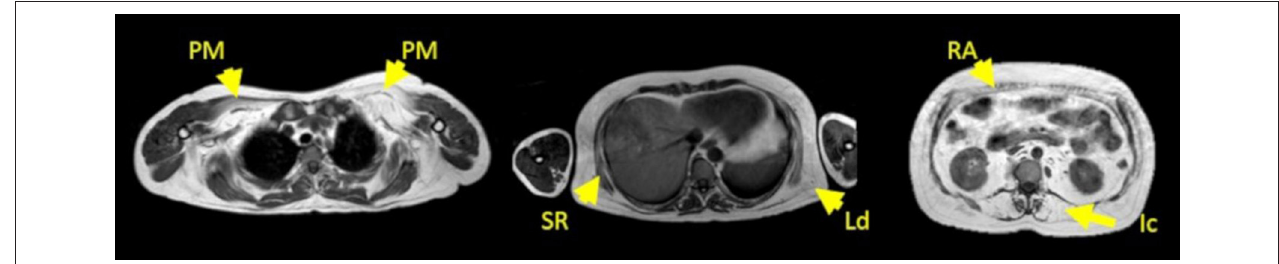
FIGURE 4 | MRI T1w of patient 14 at first visit. From left to right, first image corresponds to shoulder girdle level; second image corresponds to a thoracic level, and third image corresponds to an abdominal level. Yellow arrows point to the pectoralis major (PM), serratus (SR), latissimus dorsi (Ld), rectus abdominis (RA), and iliocostalis muscle (Ic). The MRI scores at this visit were 30 points in abdominal score, 25 points in paraspinal score, and 18 points in thoracic score. The Global score was of 73